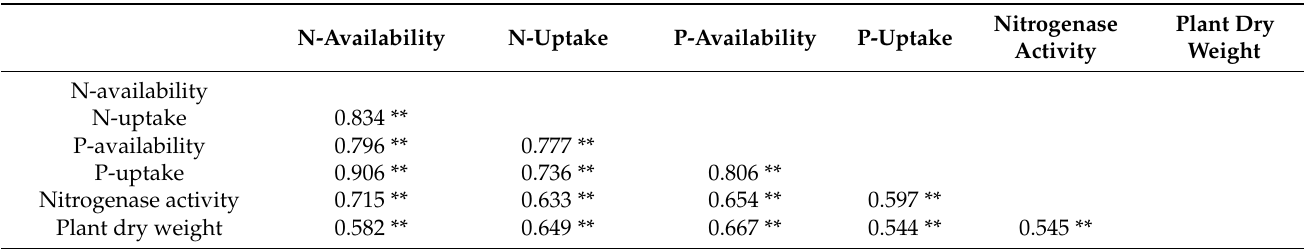
Table 3. Correlation coefficients between NP-availability and uptake in relation to plant dry weights and nitrogenase activity in the